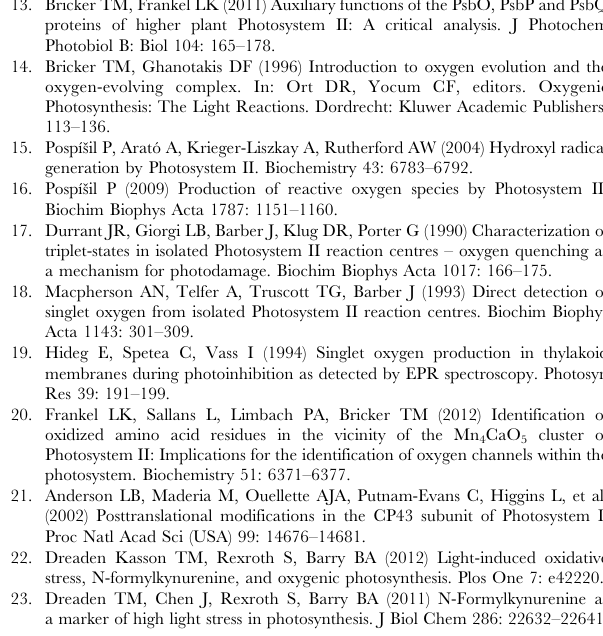
Figure S2 Mass Spectrometry Data from the Unmodi- fied Peptide. 239 FGQEEETYNIHAAHGYFG 257 R and the Oxidatively Modified Peptide 239 F + 16 G 241 Q + 14 242 E-30 EETY- NIHAAHGYFG 257 R of the D1 Protein A. Top, spectrum of the CID dissociation of the unmodified peptide 239 FGQEEETYNI- HAAHGYFG 257 R. Various identified ions are labeled. Bottom, table of all predicted masses for the y- and b- ions generated from this peptide sequence. Ions identified in the CID spectrum (above) are shown in red. The b’ ++ , b’ + y’ ++ and y’ + ions are generated by the neutral loss of water while the b* ++ , b* + y* ++ and y* + ions are generated from the loss of ammonia. B. Top, spectrum of the CID dissociation of the modified G 241 Q + 14 242 E-30 EETYNIHAAH- GYFG 257 R. Various identified ions are labeled. Bottom, table of all predicted masses for the y- and b- ions generated from this peptide sequence. Ions identified in the CID spectrum are shown in red. The b’ ++ , b’ + y’ ++ and y’ + ions are generated by the neutral loss of water while the b* ++ , b* + y* ++ and y* + ions are generated from the loss of ammonia. The p values for the unmodified and modified peptide were 10 2 8 and 10 2 9 , respectively. (DOCX) Figure S3 Mass Spectrometry Data from the Oxidative- ly Modified Peptide 130 E + 16 WE 133 L + 16 S 135 F + 16 136 R of the D1 Protein A. Top, spectrum of the CID dissociation of the modified peptide. Various identified ions are labeled. Bottom, table of all predicted masses for the y- and b- ions generated from this peptide sequence. Ions identified in the CID spectrum (above) are shown in red. The b’ ++ , b’ + y’ ++ and y’ + ions are generated by the neutral loss of water while the b* ++ , b* + y* ++ and y* + ions are generated from the loss of ammonia. The p value for this peptide is 10 2 6